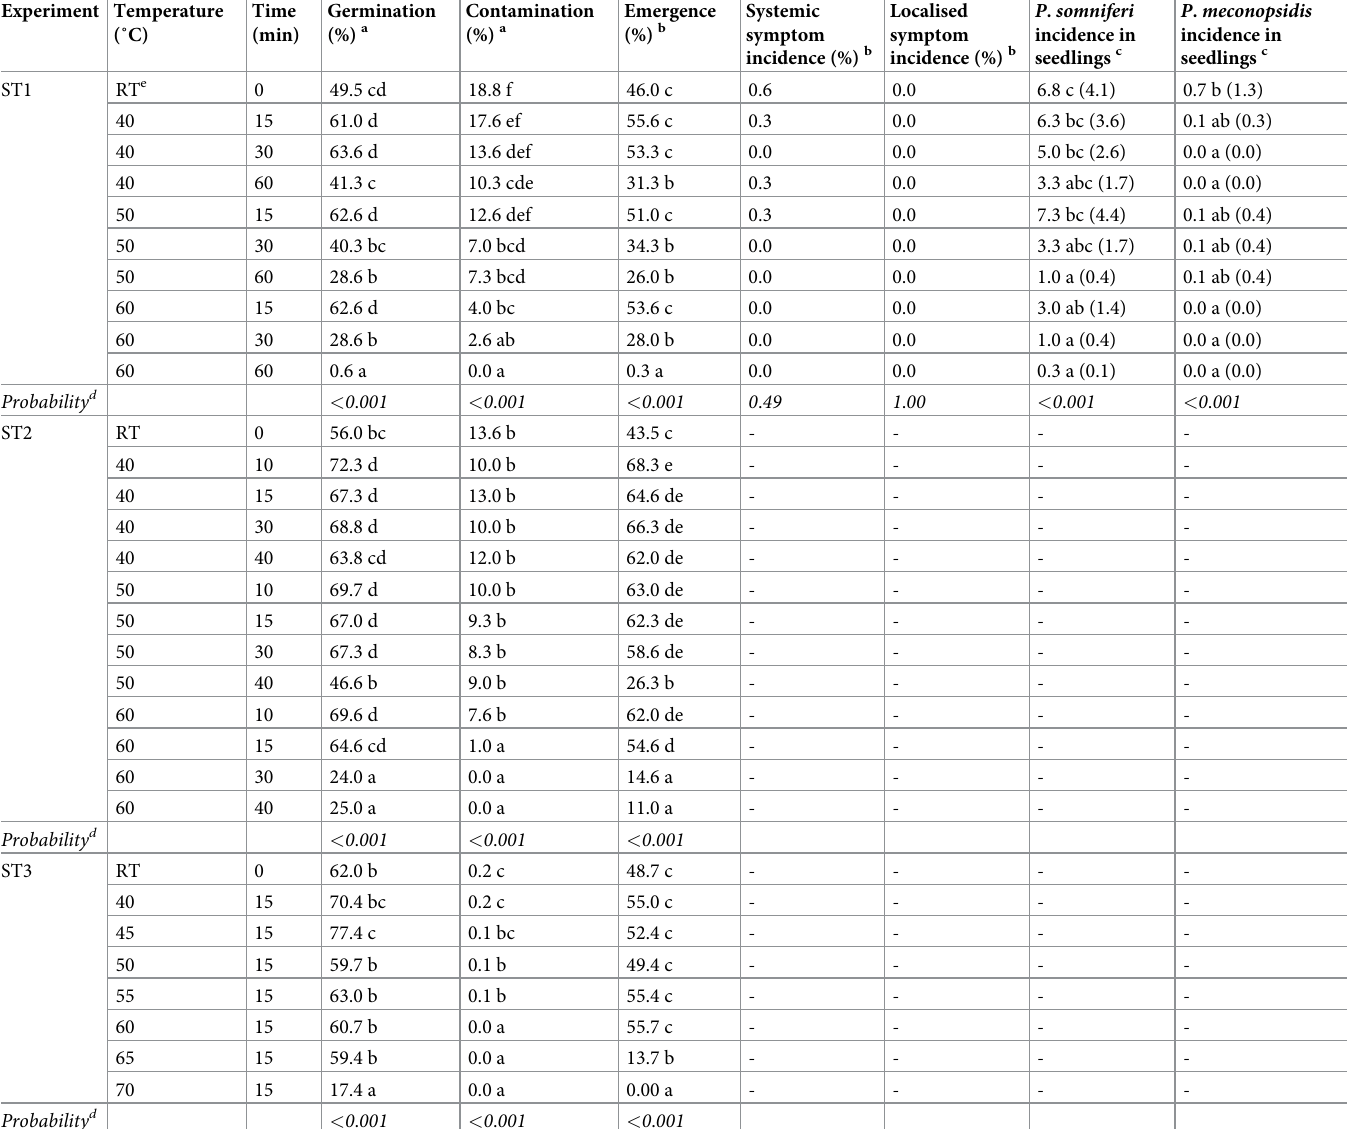
Table 5. The effect of aerated steam treatment at various temperature and time on the opium poppy seed health and controlling poppy downy mildew. Experiment Temperature